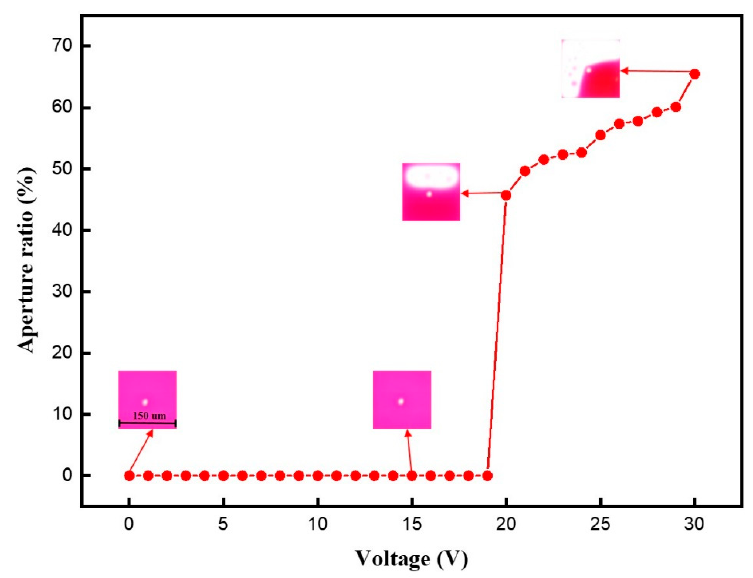
Figure 5. The aperture ratio was driven by different DC voltages. The aperture ratio was 0% when the voltage was 0–19 V. Then, the aperture ratio was 45.73% when the voltage was 20 V, and then it was increased with the increase in voltages. The maximum aperture ratio was 65.48%.